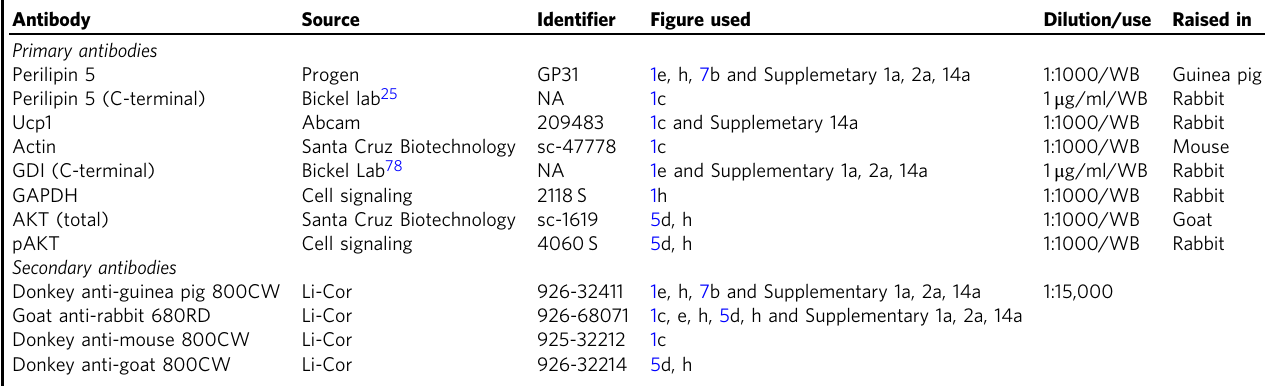
Table 1 Antibodies used for WB.